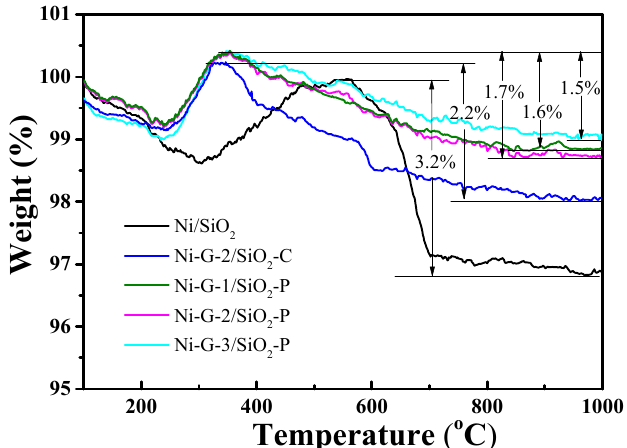
Figure 7. TG analysis of the used Ni/SiO 2 ( a ), Ni-G-2/SiO 2 -C ( b ), Ni-G-1/SiO 2 -P ( c ), Ni-G-2/SiO 2 -P ( d ), and Ni-G-3/SiO 2 -P ( e ) catalysts.